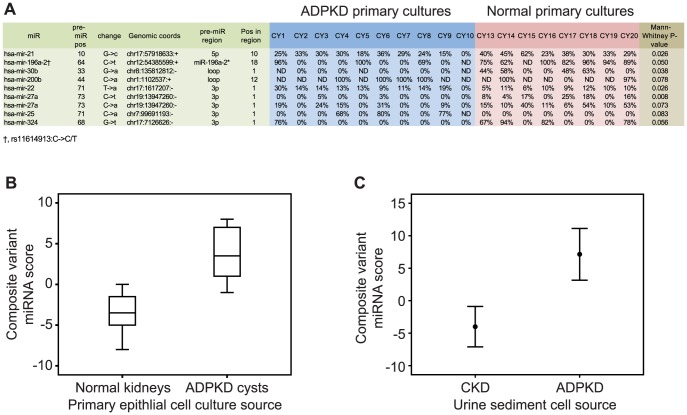
miRNA sequence variants that were found to be differentially expressed between ADPKD and non-ADPKD specimens.(A) miRNA sequence variants that were found to be differentially expressed between ADPKD cyst-derived primary cultures and normal adult kidney derived cultures (see complete list in Table S15 in File S1). (B) Box plot showing a composite score derived from the information in (A). The median frequency of each miRNA variant across the samples was used to generate the score; 1 point was added (or reduced) for each miRNA variant with frequency above (or below) the median frequency. (C) Bar plot showing a composite score derived in a manner similar to (B) from patient' urine sediment cell sequence data (contributing miRNA variants are depicted in Table S16 in File S1).